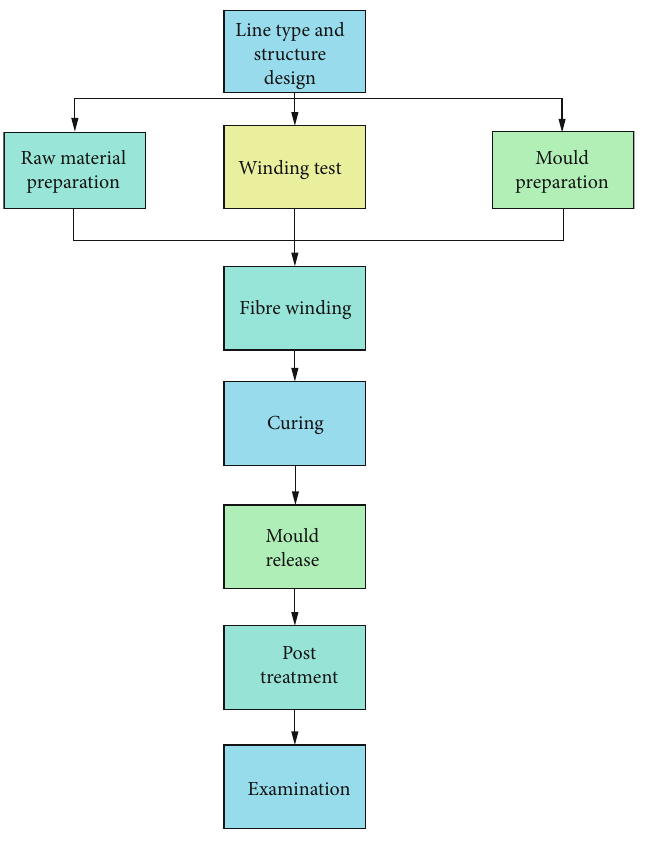
Figure 1: NOL ring fabrication preparation. Table 1: Mechanical characteristics of composites made of di ff erent fi